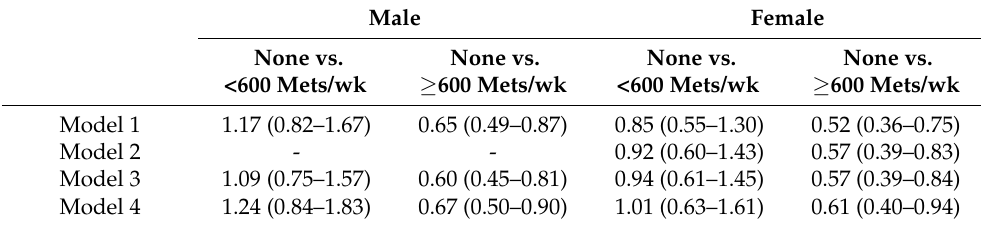
Table 3. Risk analysis of recreational PA on waist